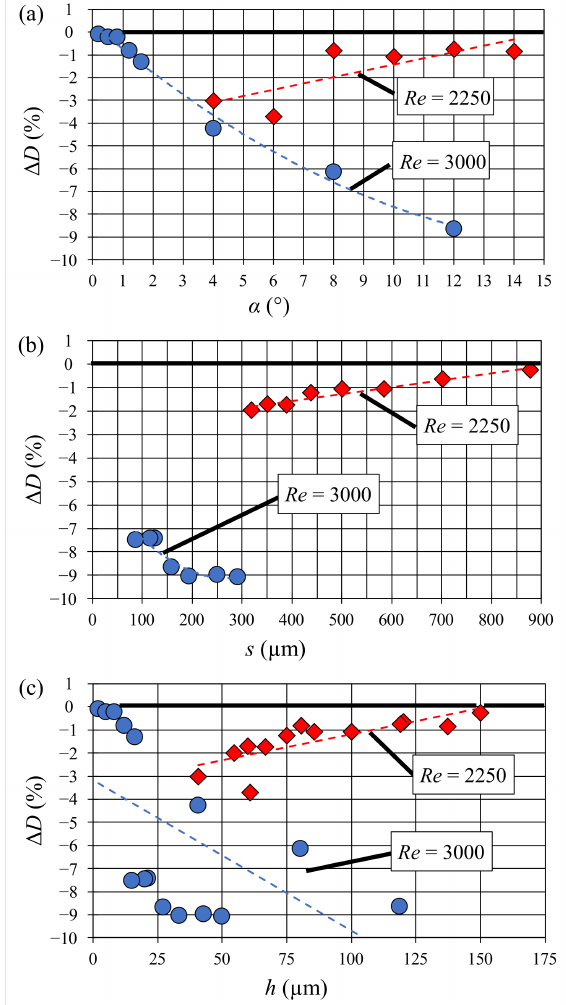
Figure 3. Simulation results: dependence of drag reduction on the principal parameters of the riblet geometry: ( a ) angle of primary facet ( b ) spacing between riblets, and ( c ) riblet